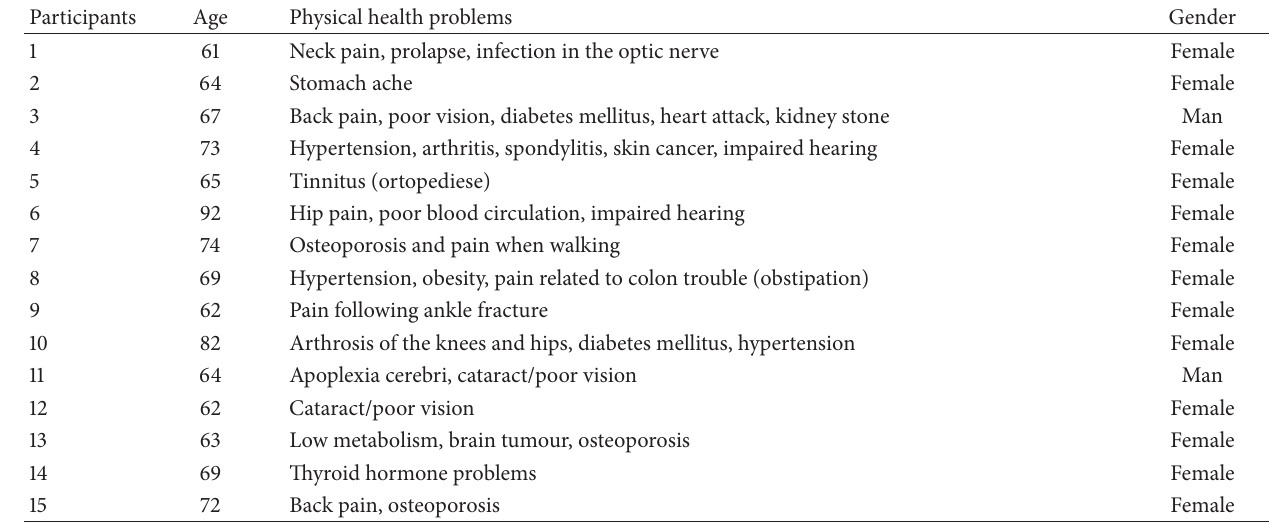
Table 1: Physical health problems reported by the participants.